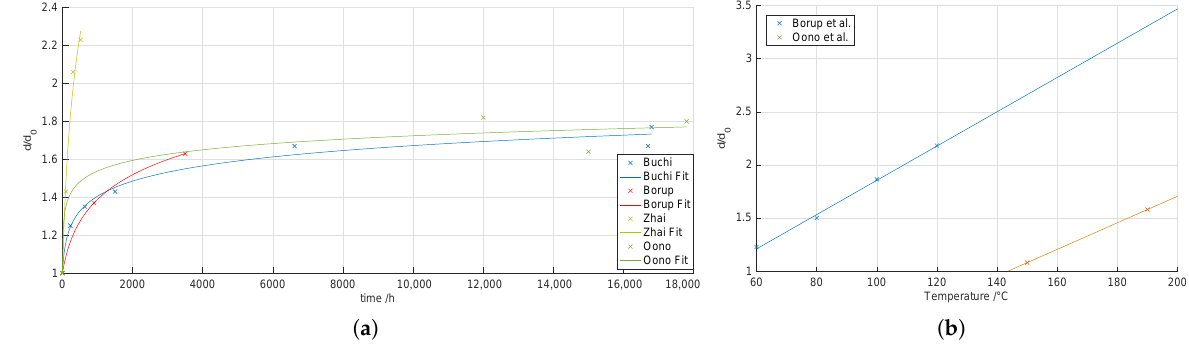
Figure 3. Evolution of d/d 0 and its dependence on temperature. ( a ) Logarithmic fit of d/d 0 over time. ( b ) Ratio d/d 0 as a function of temperature. Data from Büchi et al. [18], Zhai et al. [56] and Borup et al. [15] were obtained after 1500 cycles ( ∼ 500 h), and data from Oono et al. [39] were obtained after 1029 h and 1250 h at 150°C and 190°C, respectively.